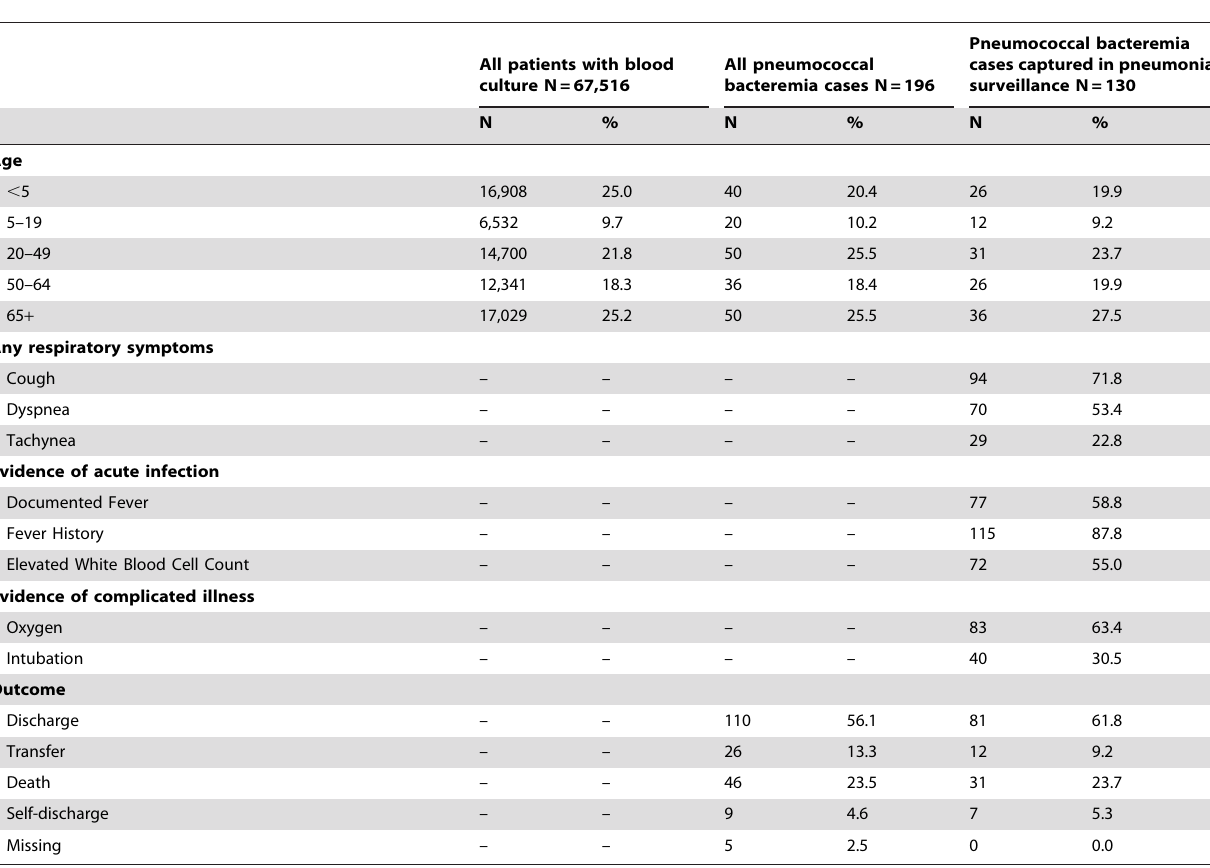
Table 1. Clinical characteristics of patients with blood culture and hospitalized pneumococcal bacteremia cases in rural Thailand,